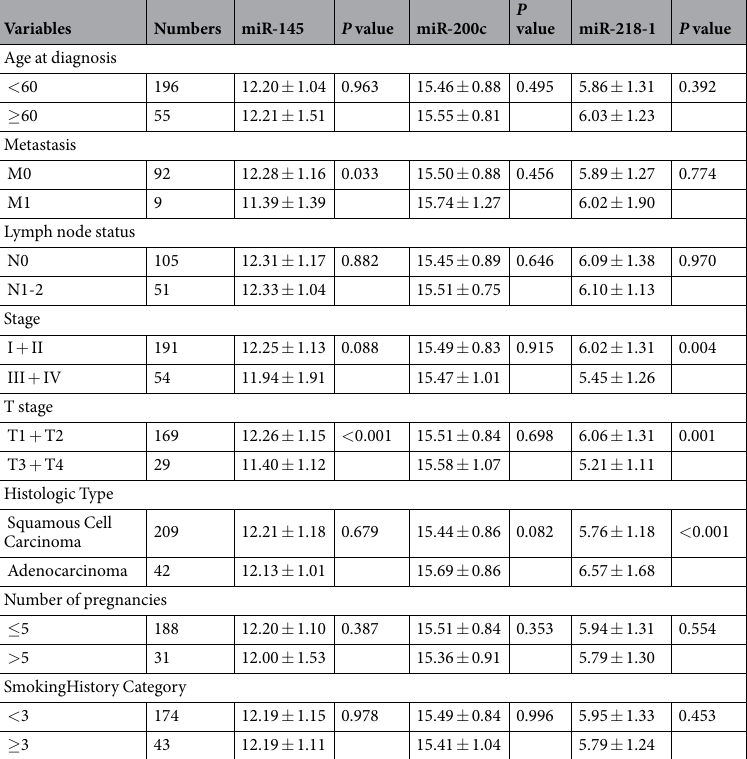
Table 2. Association of three miRNAs and clinical features.